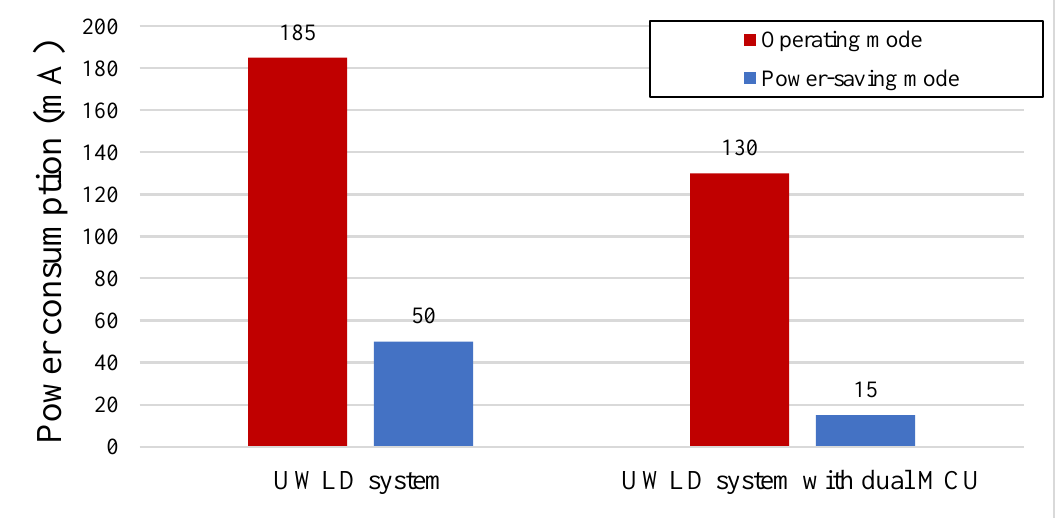
Figure 13. Power consumption of single-MCU and dual-MCU system, presenting the energy efficiency improvement with the dual-MCU system in both operating mode and power-saving mode. A 30% and 70% improved energy efficiency is shown under the operating mode and power-saving mode, respectively.